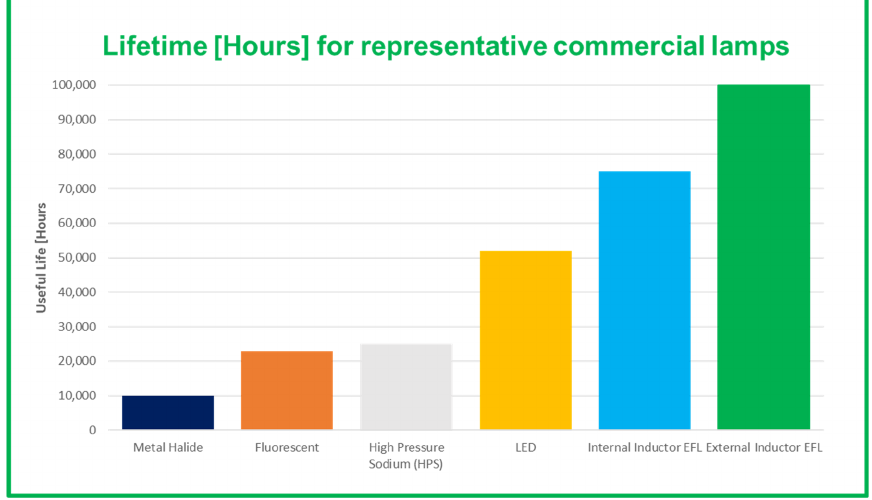
Figure 1. Lifetime, referred to lm/W compared to new lamp, below 50% for representative commercial lamps.